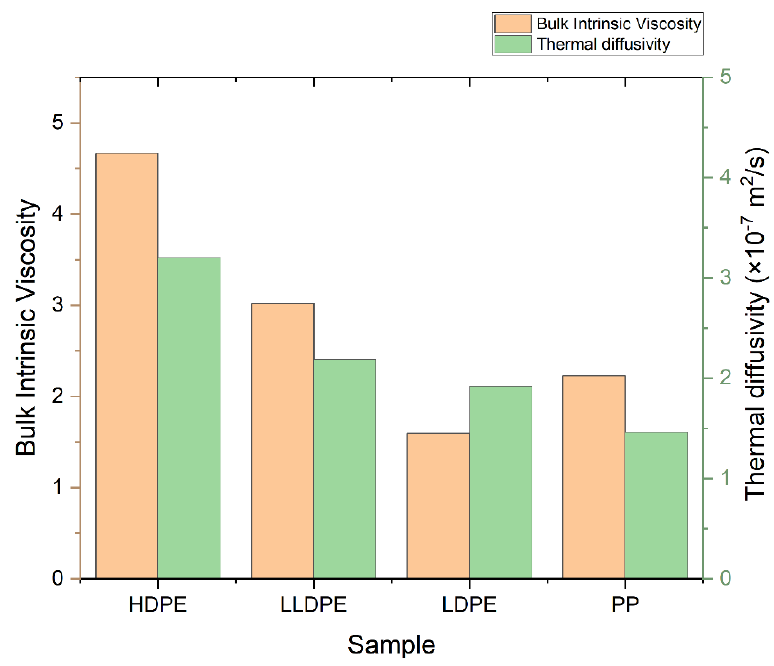
Figure 5. Bulk intrinsic viscosity and thermal diffusivity of PP, LDPE, LLDPE, and HDPE.